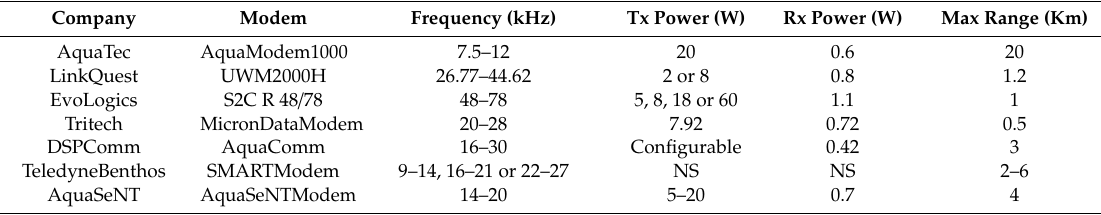
Table 2. Commercial Underwater Acoustic Modems.